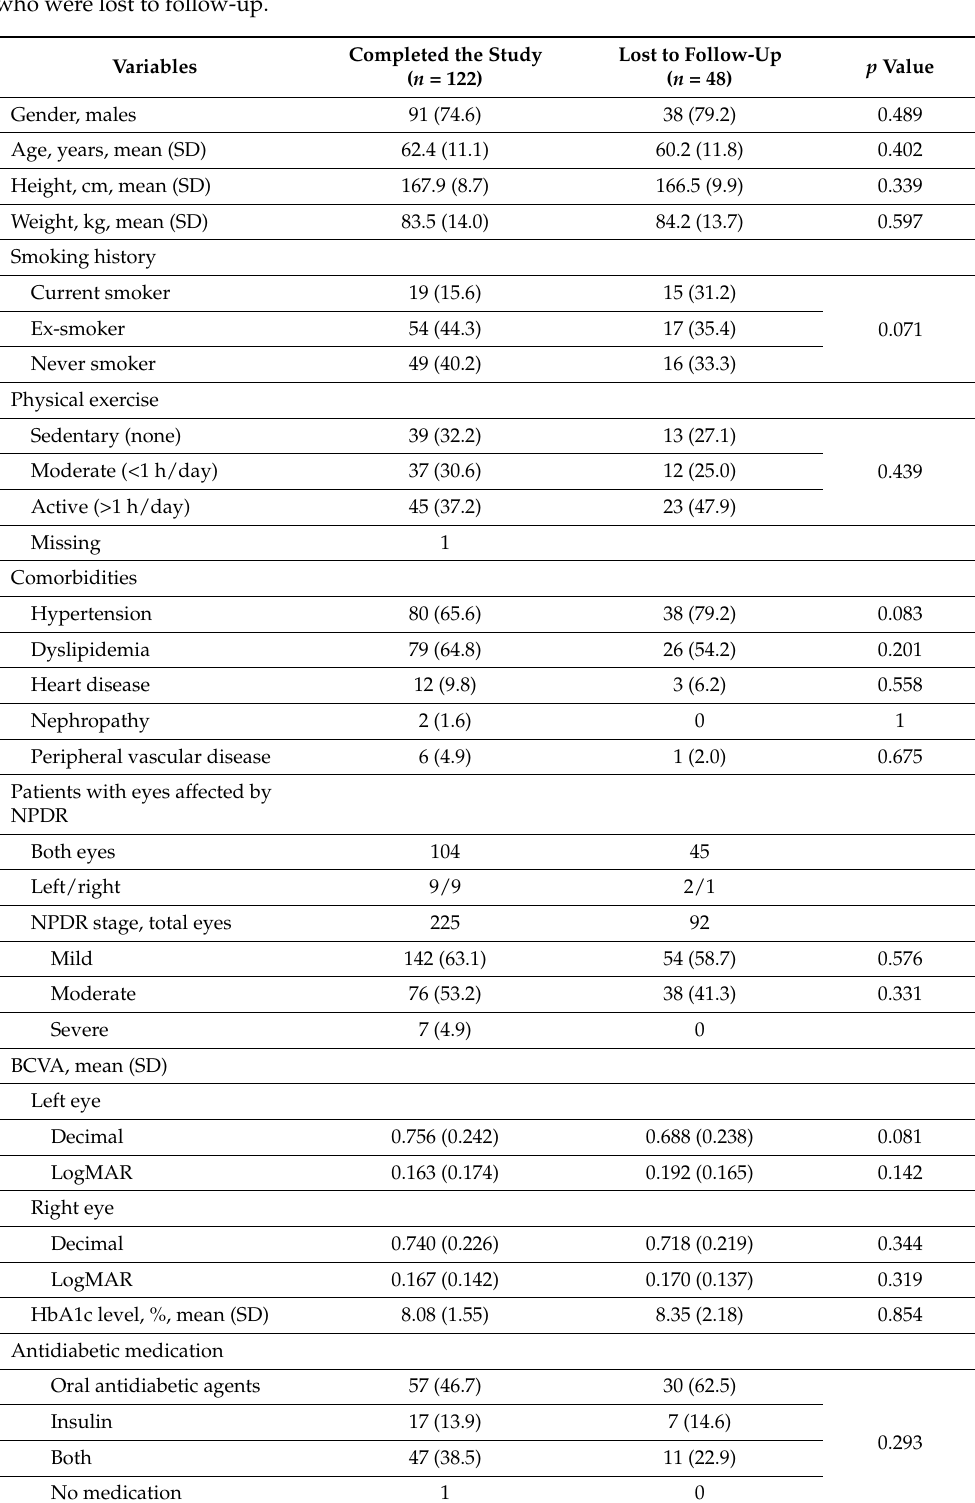
Table 3. Demographic and clinical characteristics of patients who completed the study and patients who were lost to